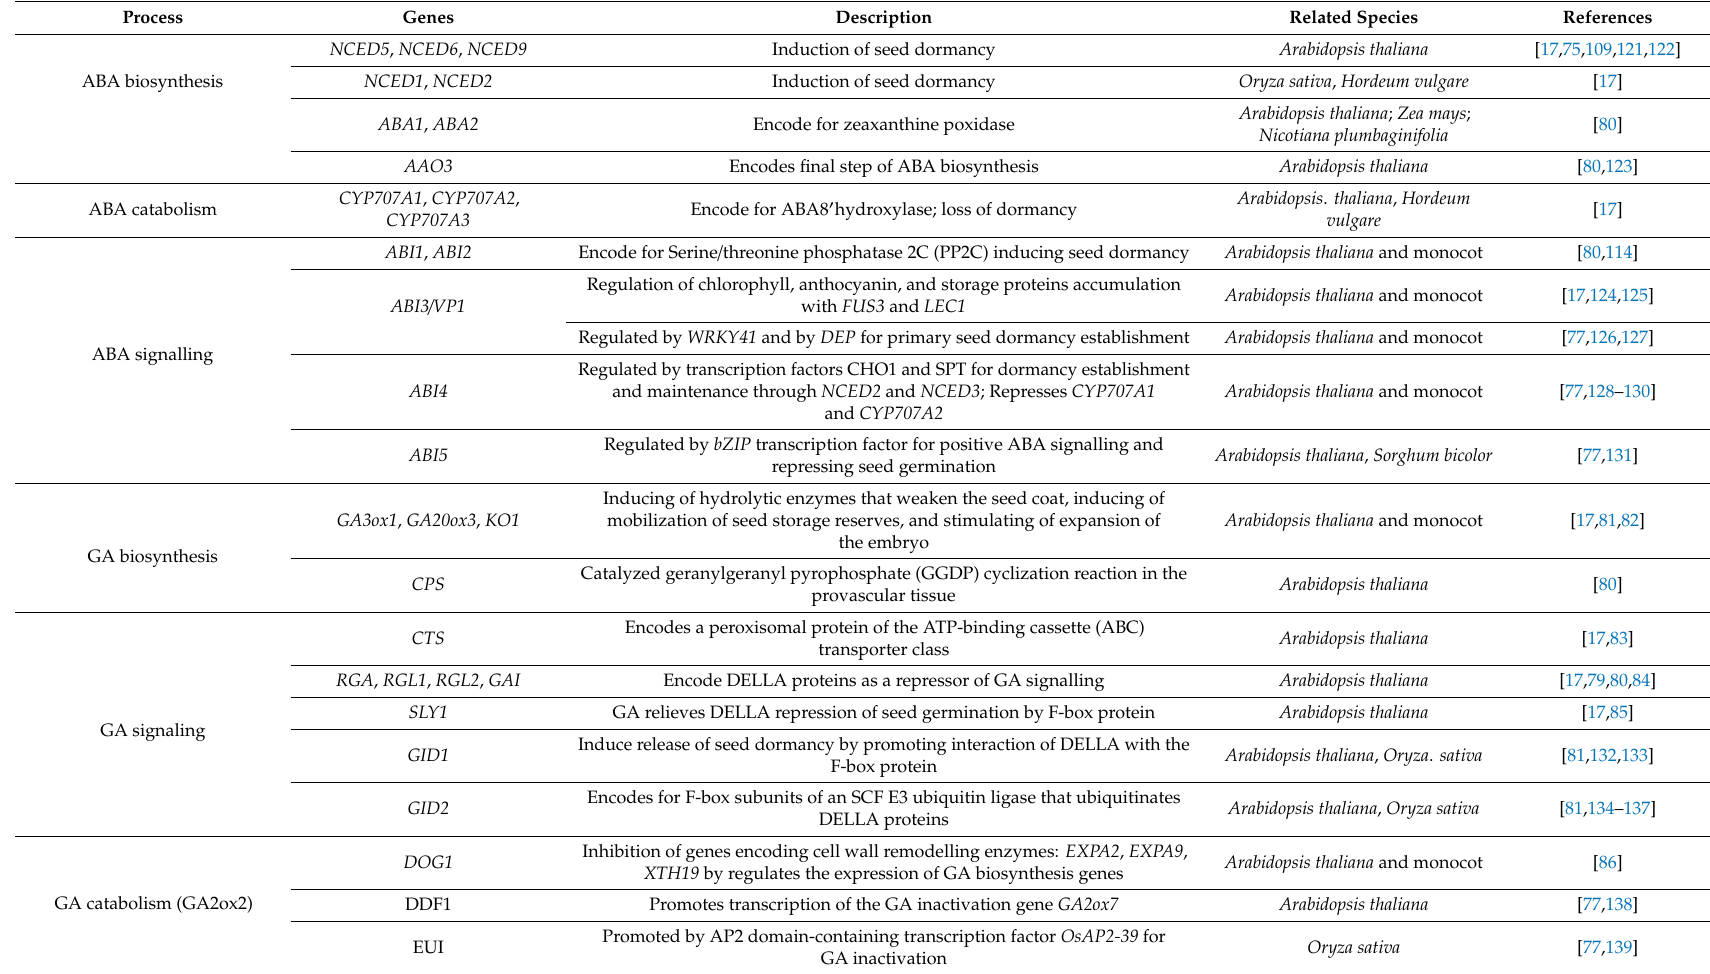
Table 4. Processes and genes involved in seed dormancy